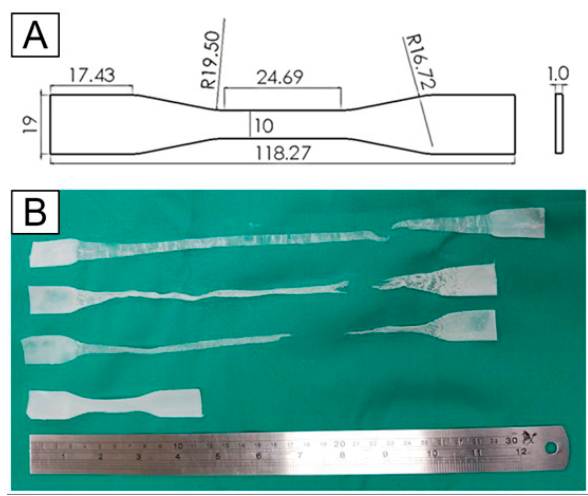
Figure 4. ( A ) Layout and dimensions of the tensile test, ( B ) photo of specimens before and after the tensile tests.